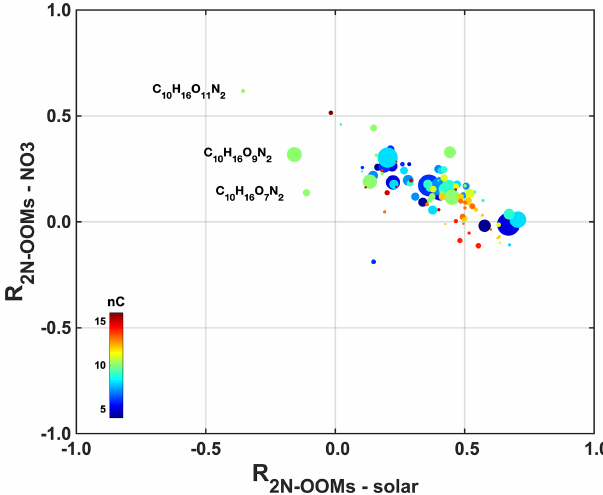
against R 2N-OOMs-solar for 3